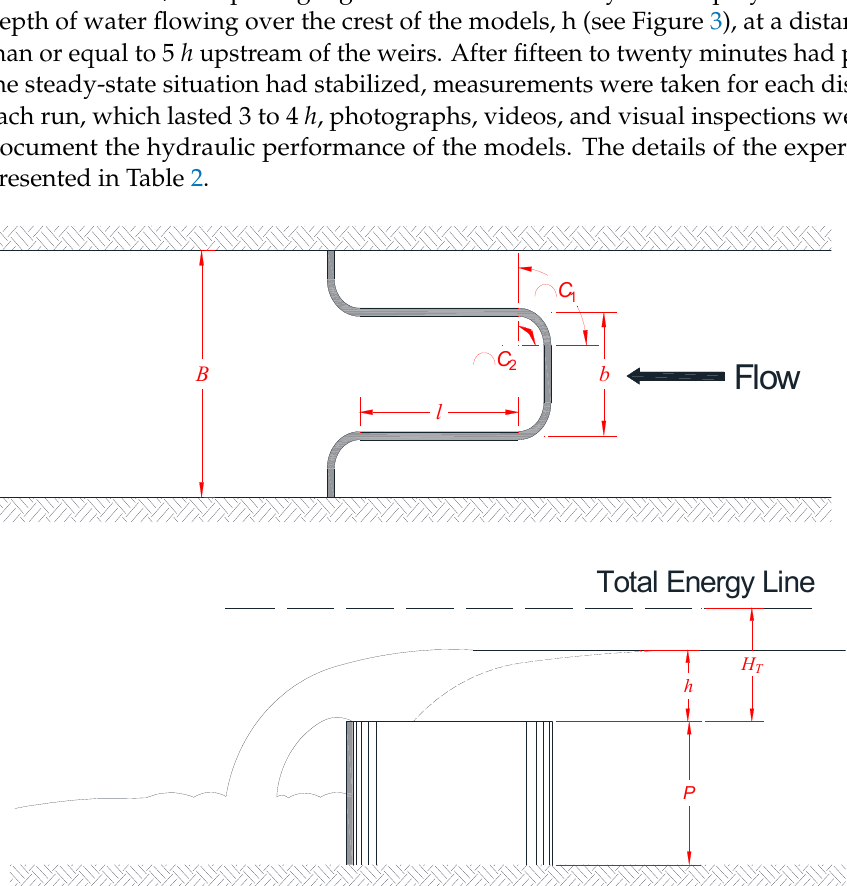
Figure 3. Illustrative chart of the flow over the rectangular labyrinth weirs. Table 2. Details of the experimental runs.